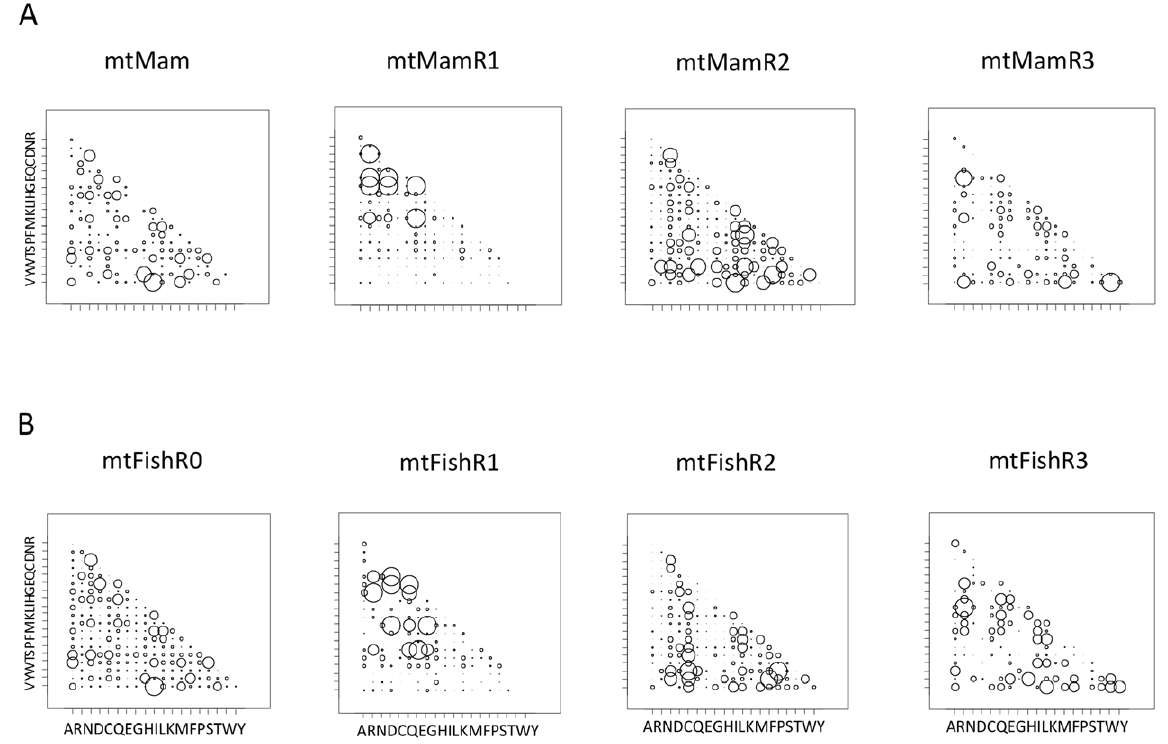
Figure 4. Plots of empirically estimated rate matrices ( R ) for complete and partitioned sets of (A) mammalian and (B) fish mitochondrial sequences. Exchangeability parameters of the rate matrices were estimated by maximum likelihood. These parameters are plotted as circles within a 20 6 20 matrix, where the diameter of the circle is proportional to parameter value.